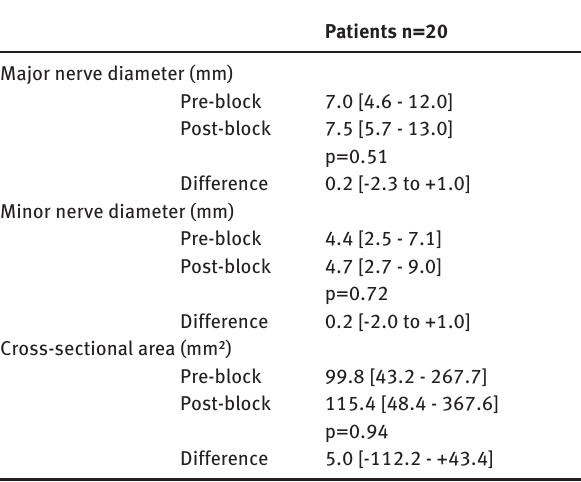
Figure 3: Post-block MRI-scan showing no signs of intrafascicular fluid accumulation inside the sciatic nerve A: MRI-scan (T2, TSE, SPAIR, axial plane) without no sign of intrafascicular fluid accumulation just proximal to bifurcation of the SN (indi- cated by arrow) but with hyperintensive fluid accumulation around the nerve (* popliteal artery; F, femur). B: Enlarged detail view of the same SN showing the distribution of hyperintensive fluid around the entire SN but lacking intrafascicular fluid accumulation (compare Figure 2B). Table 6: MRI dimensions of SN (median